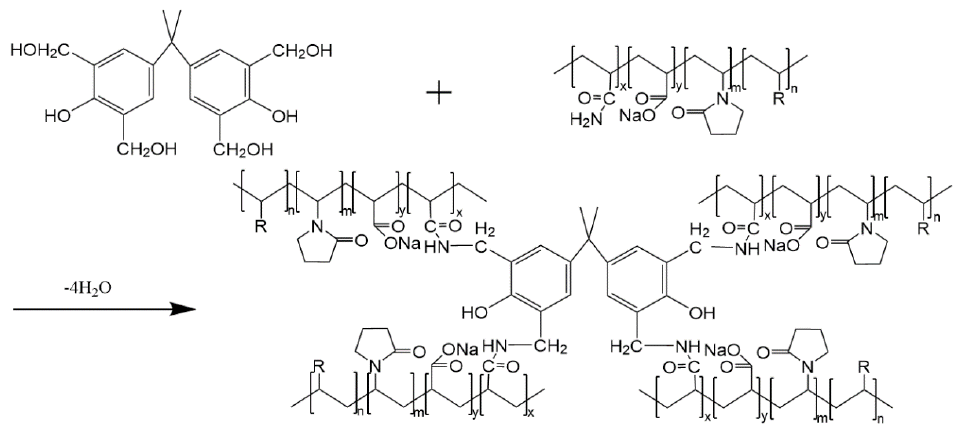
Figure 10. Schematic diagram of crosslinking mechanism between hydrophobic association polymer and phenolic resin.